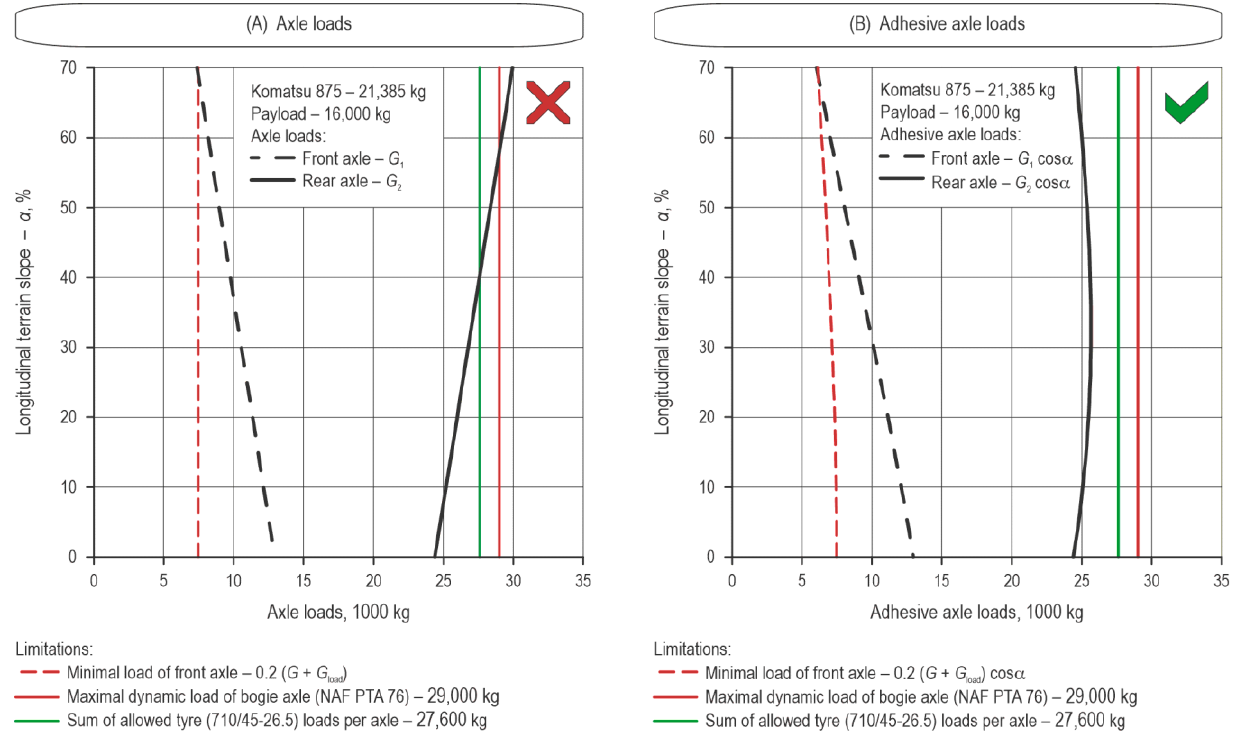
Figure 5. Axle loads and adhesive axle loads vs. terrain slope — Komatsu 875 forwarder[33-34].